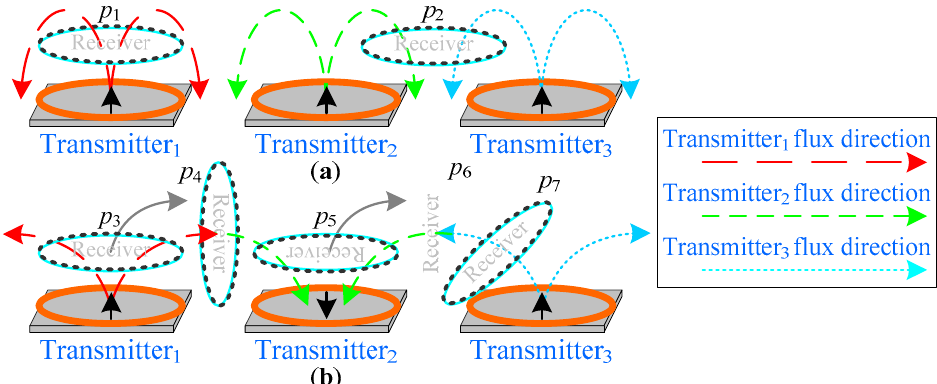
Figure 3. Receiver coil movement trajectories and expected transmitter flux directions: ( a ) conven- tional solution and ( b ) proposed solution.